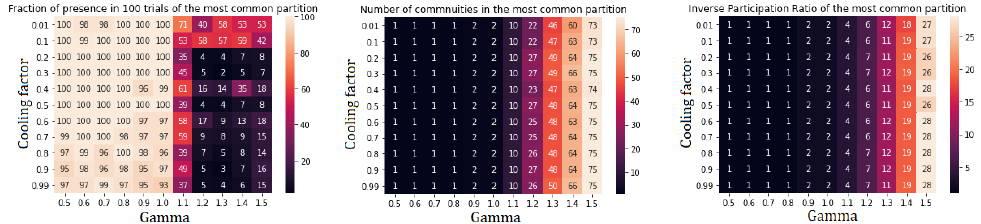
Figure A1. Performance indicators for Spin Glass algorithm applied to the whole StartupBlink network. Two communities are found: community 0 (49 nodes) and community III (51 nodes).